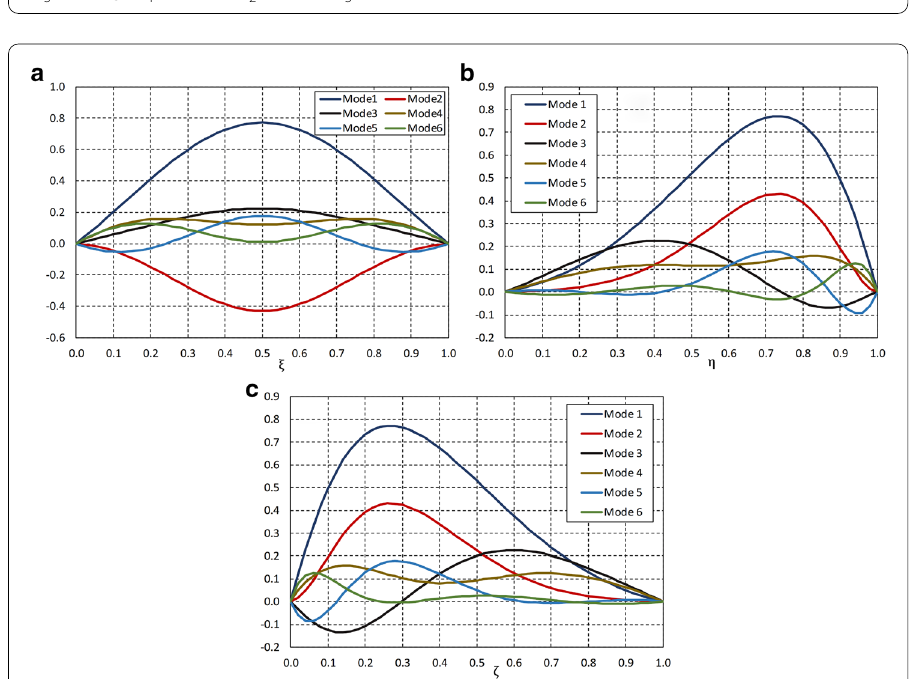
Fig. 10 SAR of the NURBS-based mapping: a M T M T